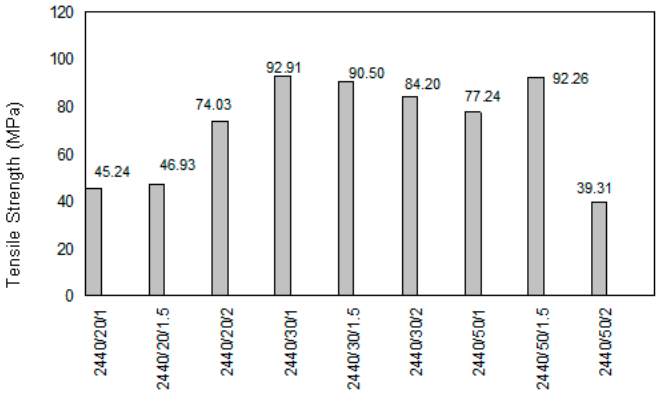
Figure 8. Tensile test results of 2440 rpm.